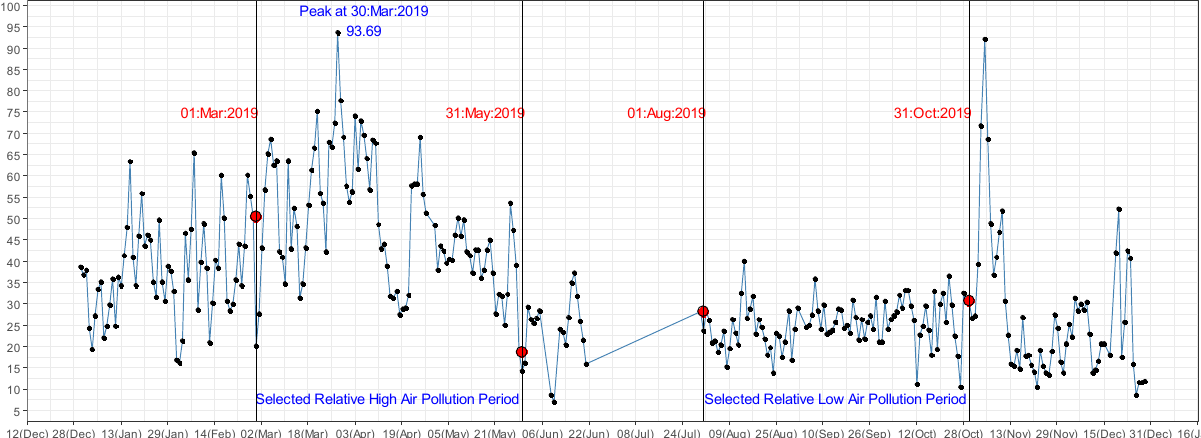
Figure 2. Variation of average daily PM 2.5 ( µ g/m 3 ) over the period 1 January 2019 to 31 December 2019 in Kandy. Table 3. Descriptive statistics of daily air pollution levels and daily respiratory disease hospital admissions in two air pollution periods (in selected